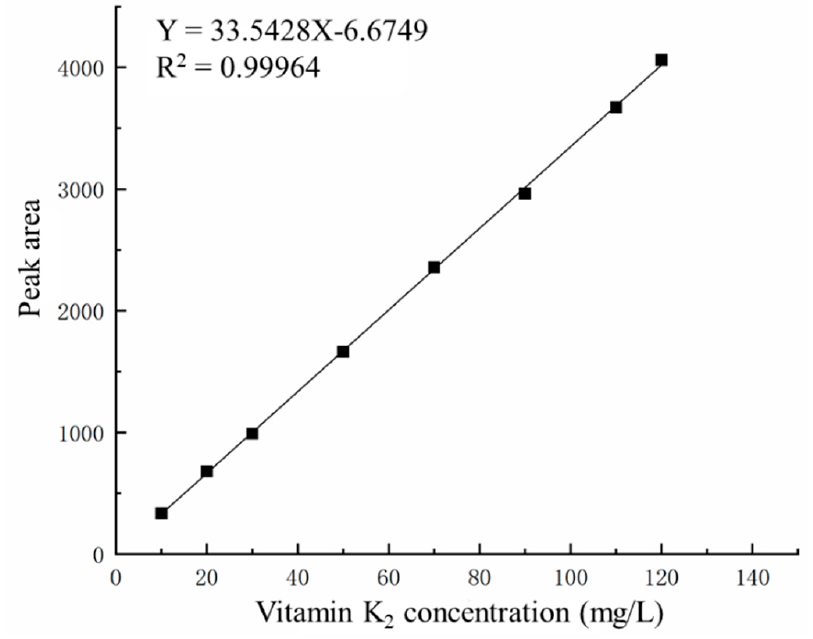
Figure 4. Standard curve of vitamin K 2.